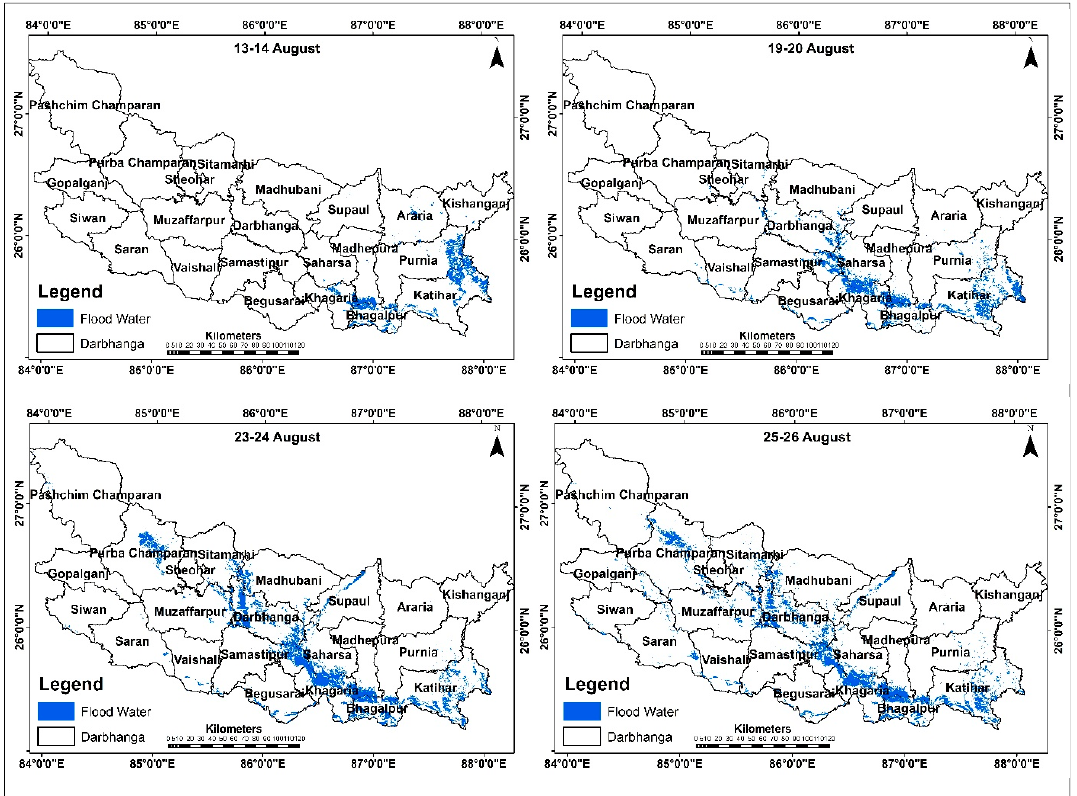
Figure 4. Flood water extent over the North Bihar districts inside Gandak and Kosi river’s catchment. Only selected major flooding dates are shown.